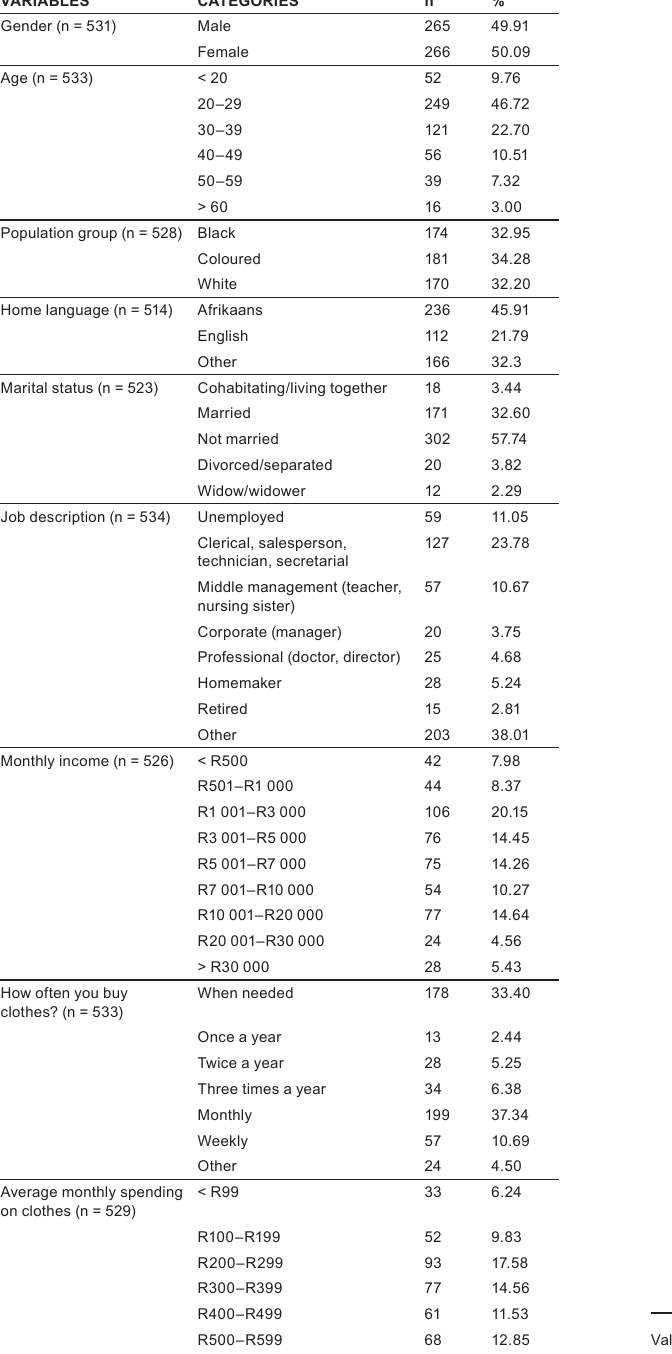
TABLE 1 Demographic profile of respondents – Mall intercept study